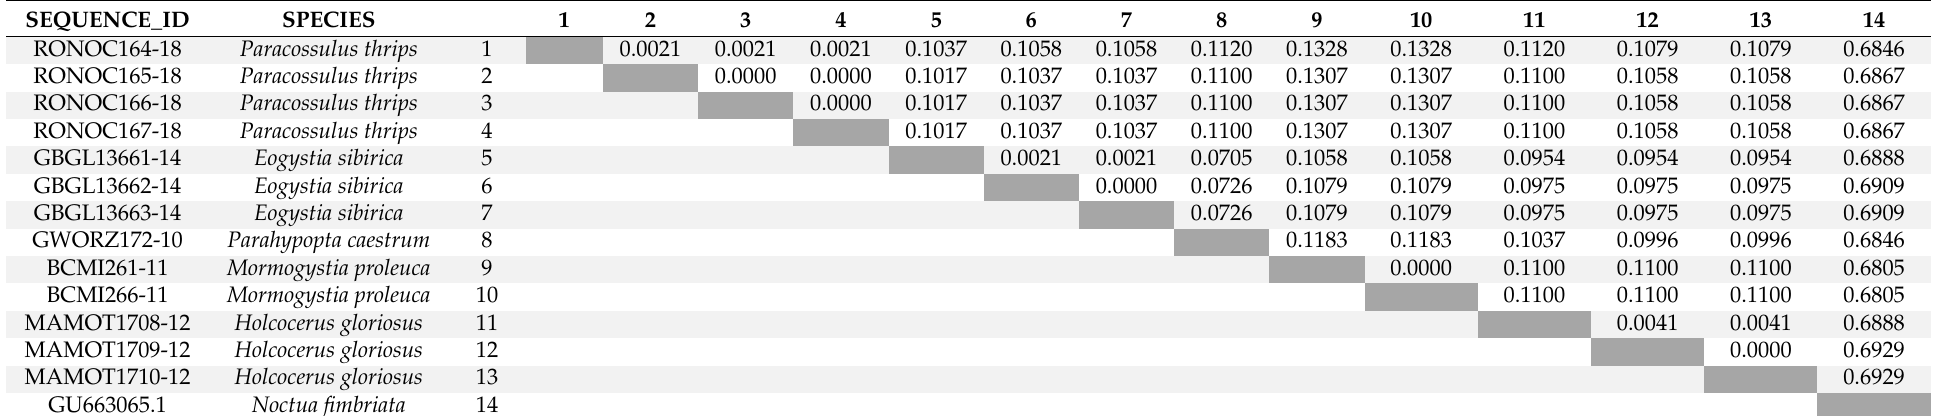
Table 3. The genetic distances between P. thrips and the species from the same clade. The genetic distances from the out-group are presented in column 14.